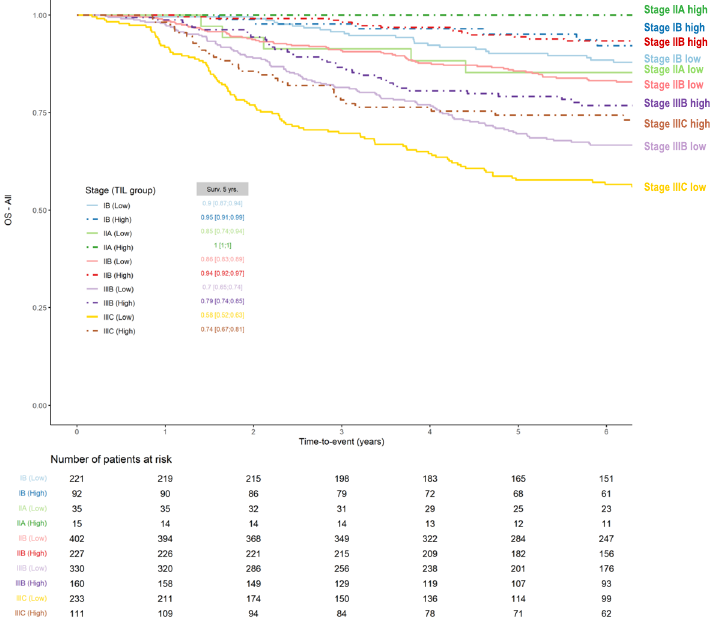
Fig. 2 Kaplan – Meier curves of overall survival of triple-negative breast cancer patients treated with anthracycline-based chemotherapy with or without taxanes, according to clinical prognostic stage and TILs. Clinical prognostic stage assigned stage for all patients based on history, physical examination, imaging studies performed (but not required) and relevant biopsies. Clinical prognostic stage is determined by T, N, M, tumor grade, as well as subtype information using human epidermal growth factor receptor (HER2), estrogen receptor (ER), and progesterone receptor (PR)- status. Supplementary Tables 1 and